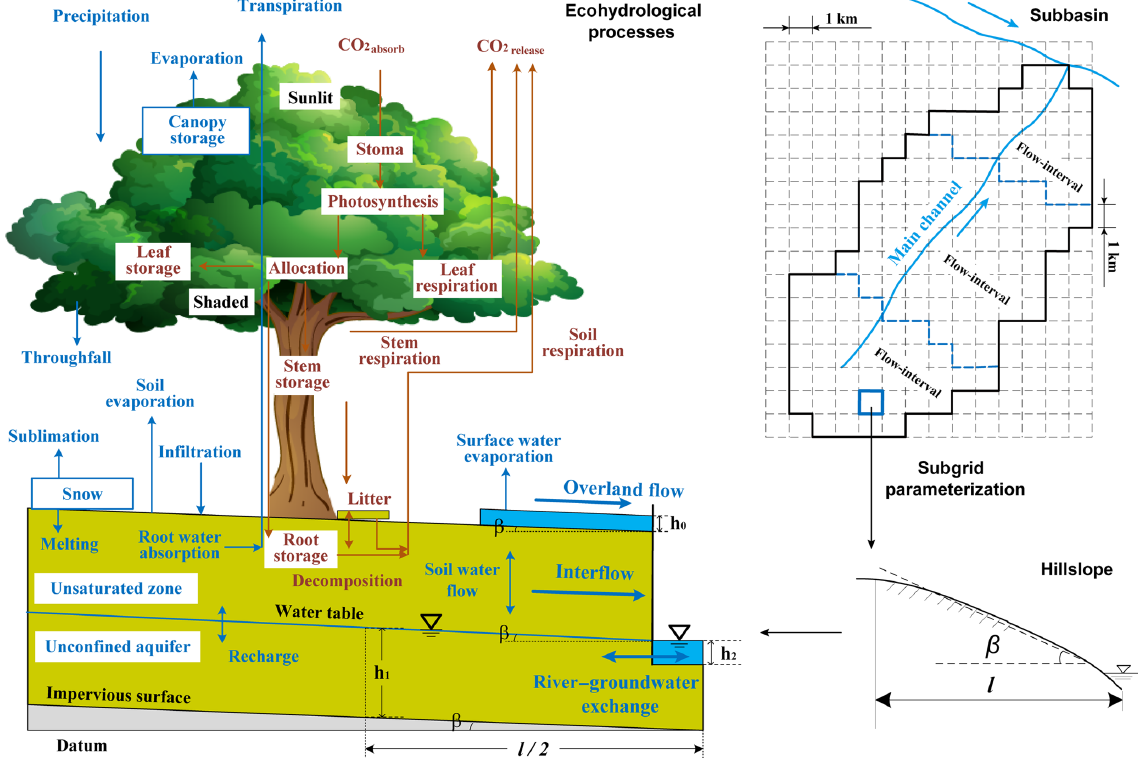
Figure 2. Structure and main ecohydrological processes for the land surface hydrological model CLM-GBHM (modified from Jiao et al.,